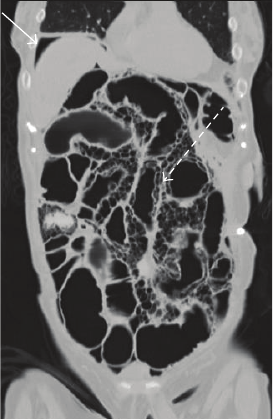
Figure 4: Coronal CT image demonstrates pnemo periotneum in the right upper quadrant of the abdomen, above the liver (arrow). Multiple large “cysts” are seen within multiple loops of small bowel (dashed arrows), consistent with “pneumatosis cystoides intesti- nalis” seen in this patient with